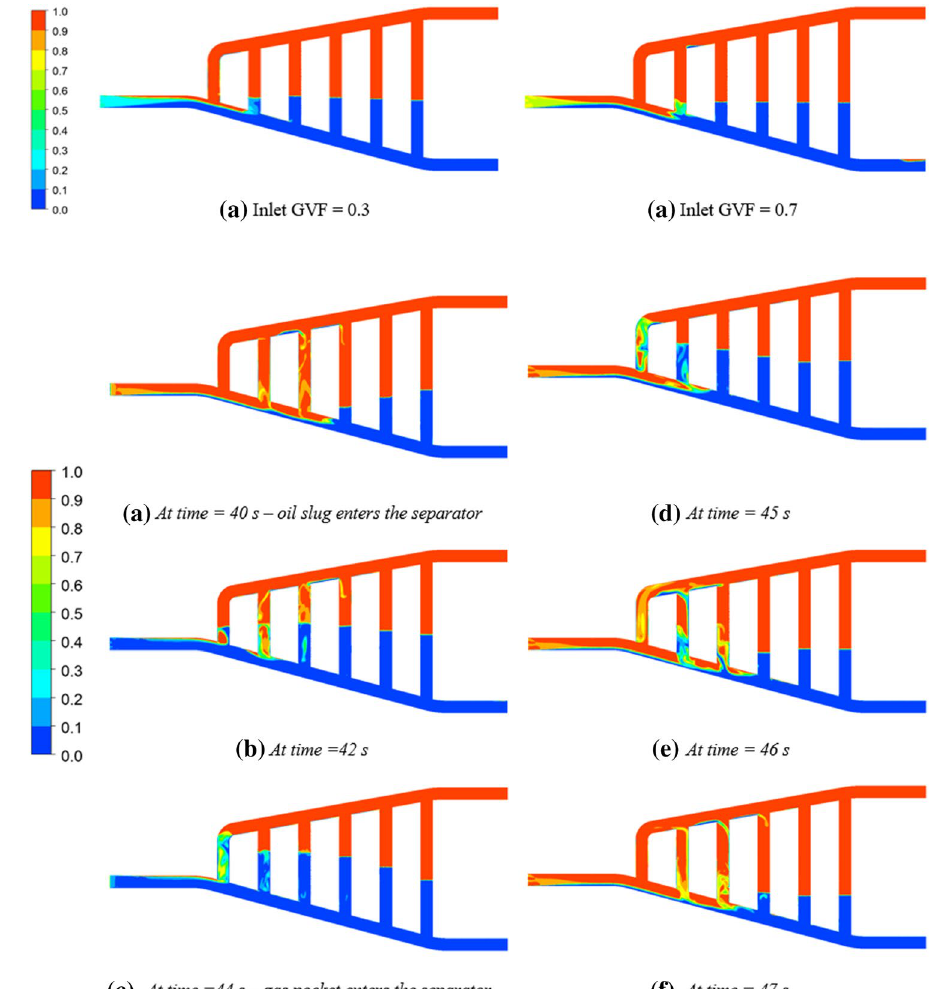
Fig. 8 GVF plot of differ- ent outlet gas pressures. Note Screenshots are made at the end of the total simulation time